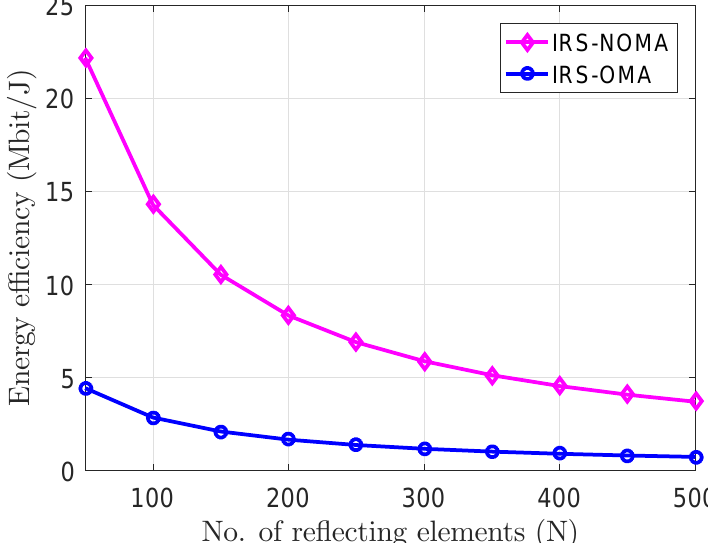
Figure 3. EE trends against various numbers of reflective elements.